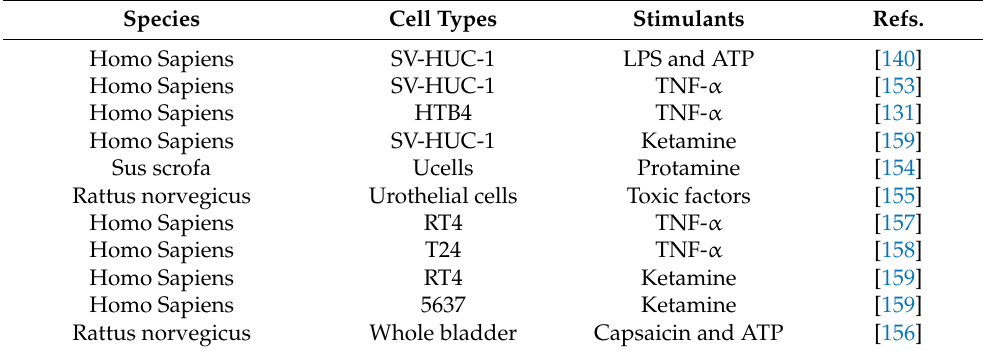
Table 4. Cell models of IC/BPS in recent